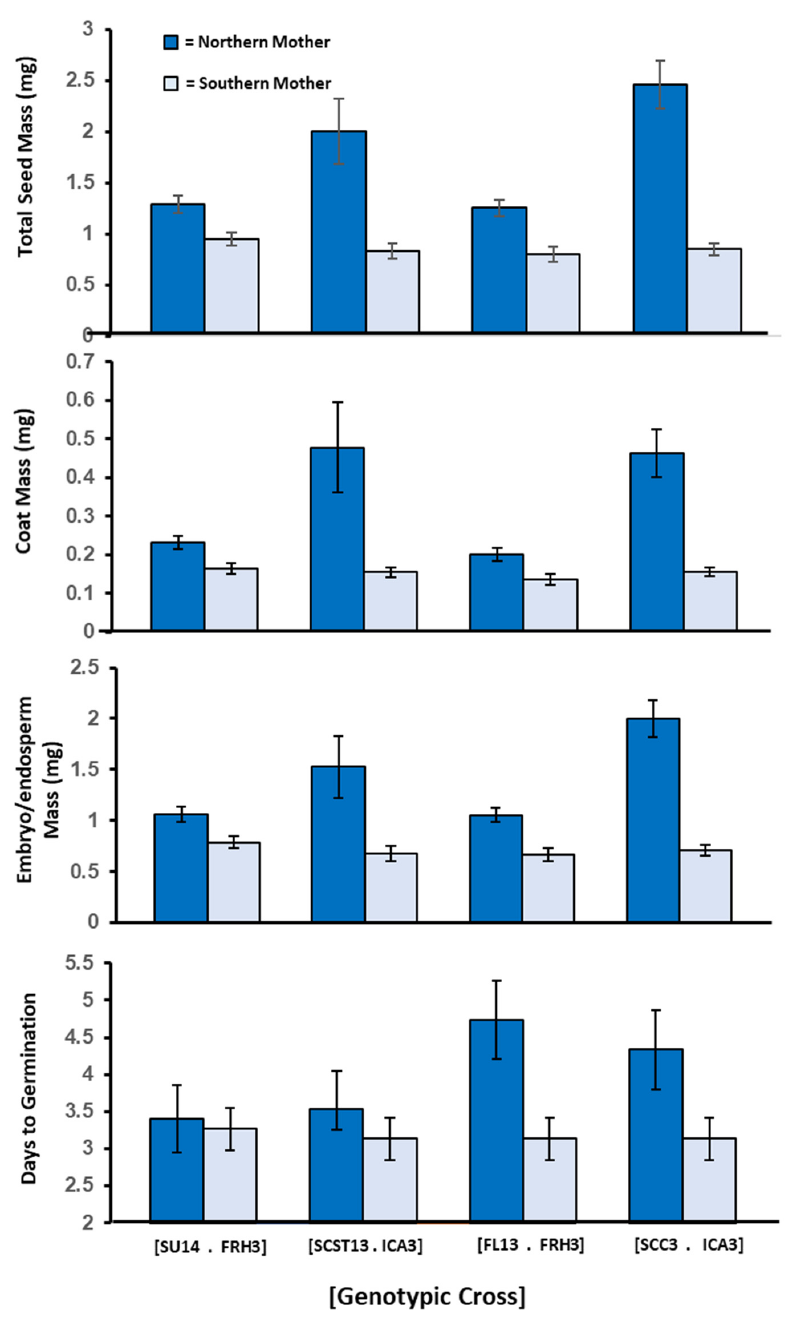
Figure 3. Experiment 2: Mean ± 95% CI for seed components and days to germination shown by reciprocal cross and maternal parent for each of four reciprocal genotypic crosses. Genotypic crosses are identified by brackets. Each parental genotype is identified by grandparental wild population and maternal ID. Dark blue = northern mother/southern father, Light blue = southern mother/northern father. Statistical difference between mothers within genotypic crosses were not determined, as in Figure 3, because we lacked information about clonal cross for all reciprocal pairs in this